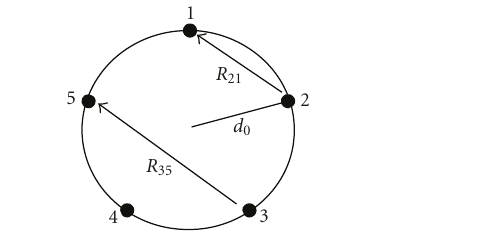
Figure 3: The ring network topology. Communication rates R 21 and R 35 are shown for reference.